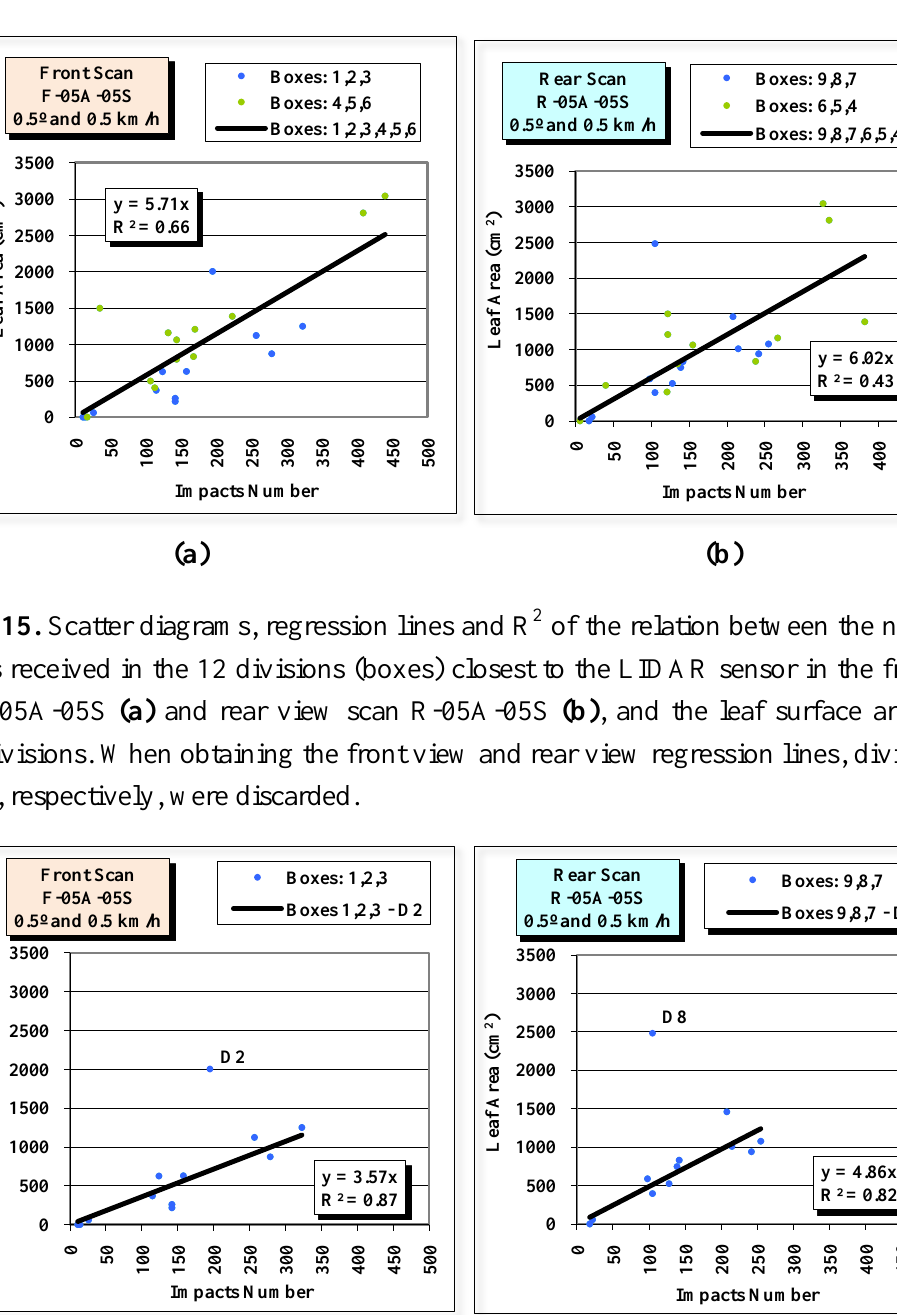
Figure 14. Scatter diagrams, regression lines and R 2 of the relation between the number of impacts received in the 24 divisions (boxes) closest to the LIDAR sensor in the front view scan F-05A-05S (a) and rear-view scan R-05A-05S (b) , and the leaf surface area of the same divisions.